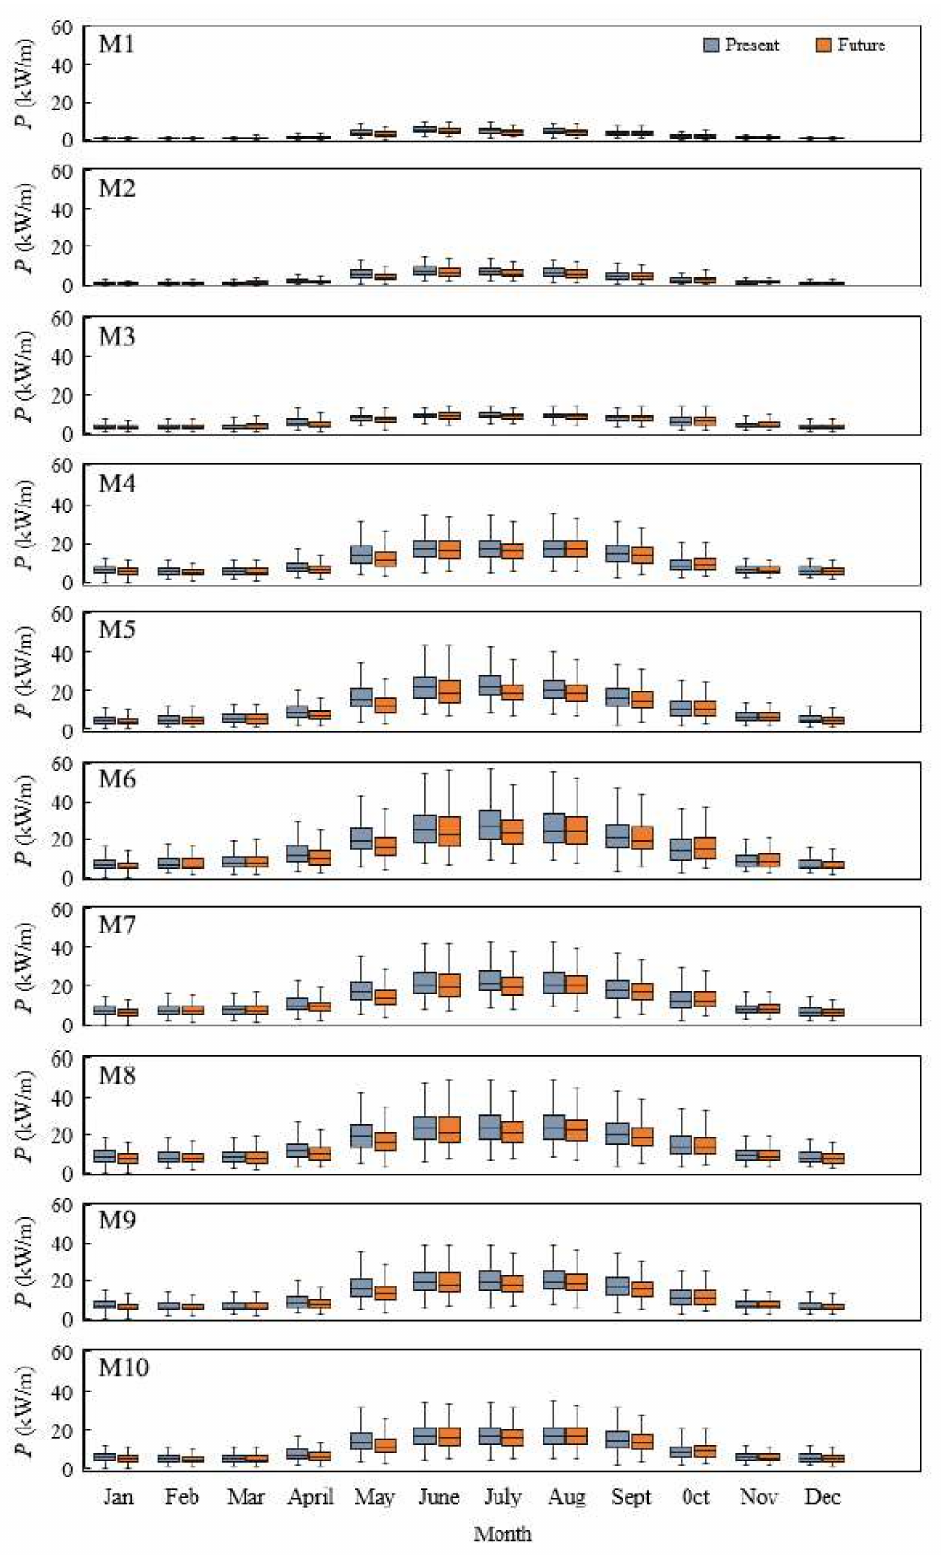
Figure 11. Box-Whisker diagrams of “present” and “future” wave power resource at locations M1 to M10. Bottom, middle, and top black lines represent first quartile, median, and the 3rd quartile. Whiskers indicate the full range of